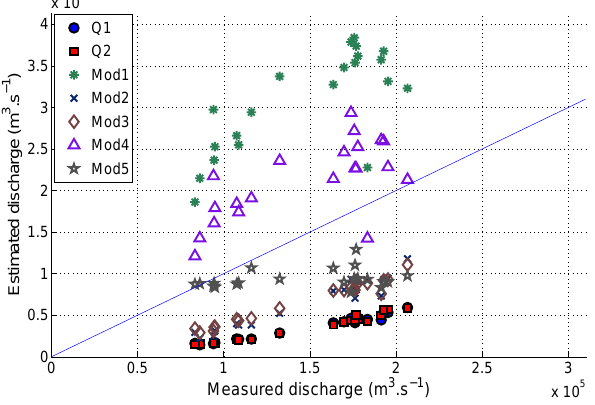
Fig. 5. Comparison of the estimated discharge with the ADCP dis- charge measurements for the Obidos dataset.